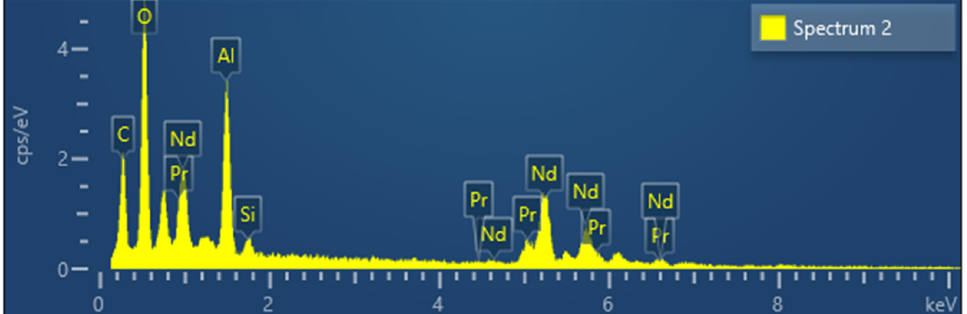
Figure 8. Typical EDS analyses of mixed REE-Oxide powders synthesized with varying reaction temperatures.